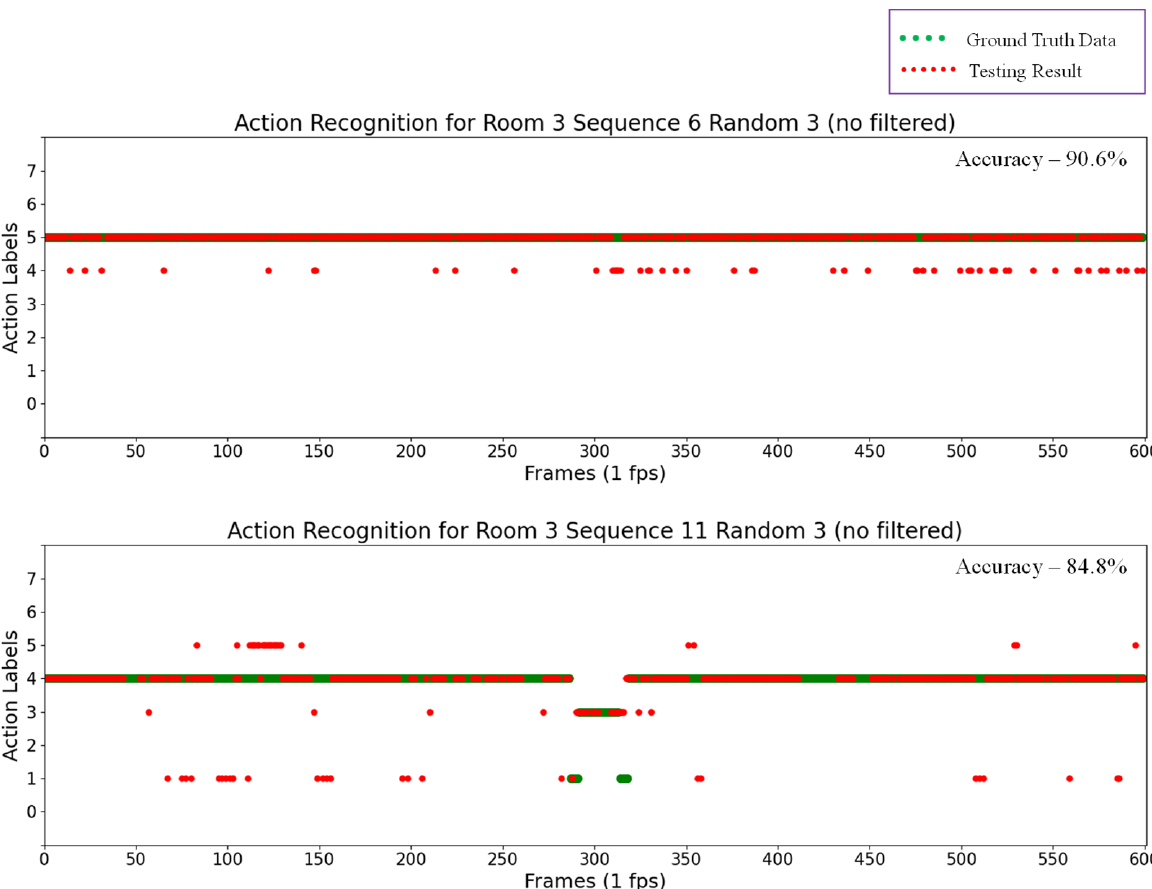
Figure 16. Action recognition results for Room 3 Sequence 6 Random 3 ( top ) and Room 3 Sequence 11 Random 3 ( bottom ).